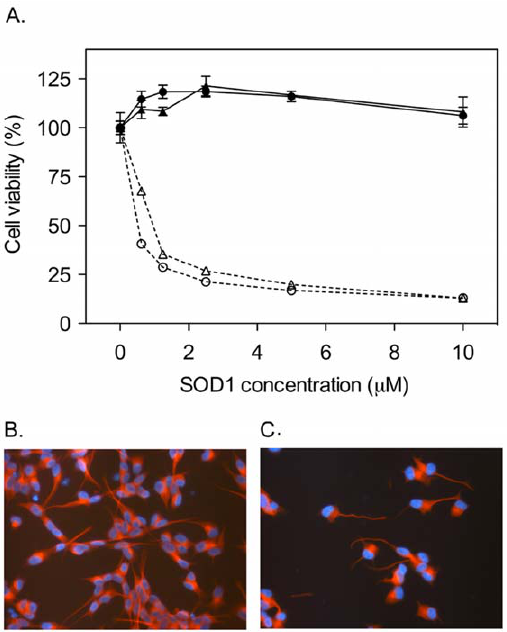
Figure 1. ApoSOD1 reduces viability of cultured cells. Apo and holoSOD1 in dimeric and monomeric form were added to the cell media of cultured SH-SY5Y cells and incubated for 72 h. Proteins were added in duplicate wells and cell viability was measured with the MTT assay. Cell viability is presented as the mean percentage viability of the buffer control 6 range. Cell morphology was visualized with immunocytochemistry, using DAPI for DNA staining (blue) and an anti-tubulin antibody for staining of the cytoskeleton (red). ( A ) Both monomeric ( # ) and dimeric ( n ) apoSOD1 induced a cytotoxic response when added in m M concentrations (calculated as monomeric SOD1 concentration for both dimer and monomer). Neither monomeric ( nor dimeric ( m ) holoSOD1 induce toxicity in the same concentration interval. ( B ) Monomeric holoSOD1 (5 m M) did not induce any morphological cell alterations after 72 h of incubation (400 6 magni- fication). ( C ) Remaining cells after exposure to 5 m M monomeric apoSOD1 for 72 h displayed an altered morphology characterized by twisted and distorted neurites (400 6 magnification).